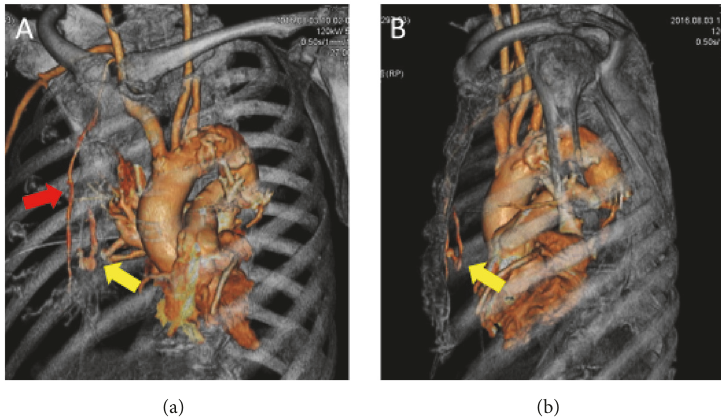
Figure 3: Three-dimensional contrast CT images. Left posteroanterior oblique view (a) and left-right view (b). The extravasation from a branch of IMA (yellow arrow) is confirmed. A red arrow shows the IMA main